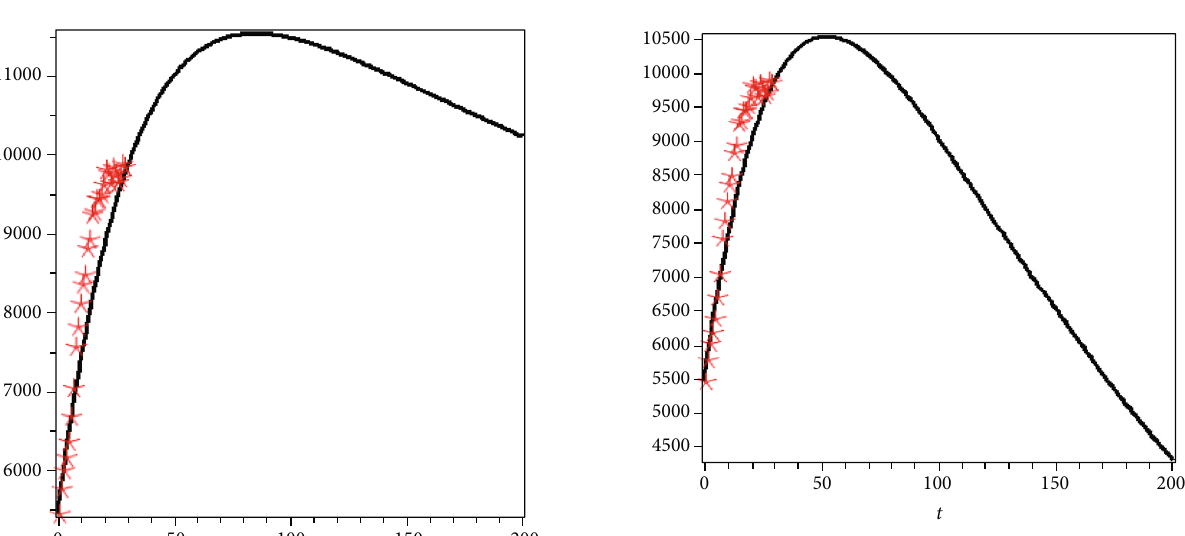
Figure 7: Compared the prediction of model (53 – 55) (black line) with real data of Saudi Arabia (red asterisks) for v = 75000